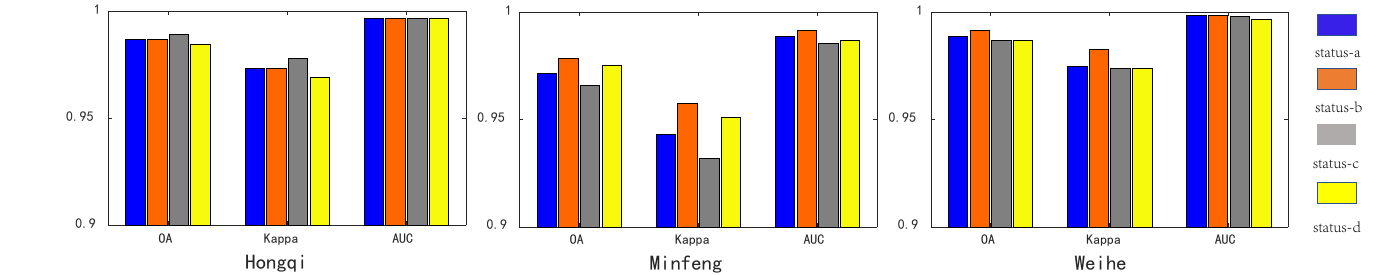
Figure 11. Different penalty parameter λ 1 , λ 2 , λ 3 combinations on OA, Kappa, and AUC values.